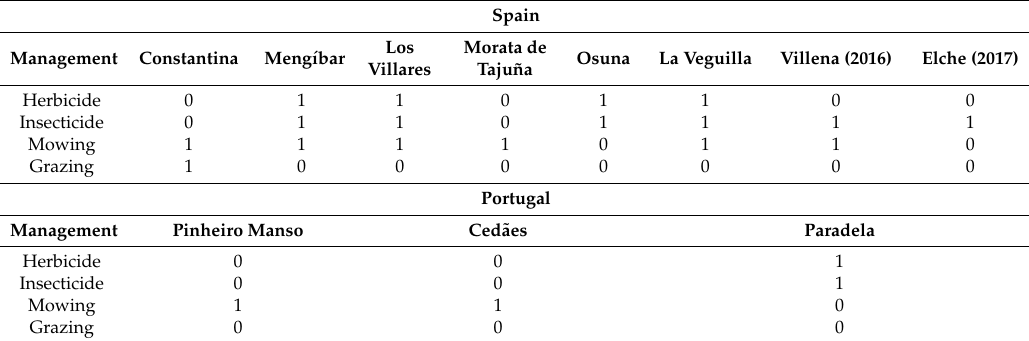
Table 1. Management practices in the different sampling sites (1 = applied, 0 = not